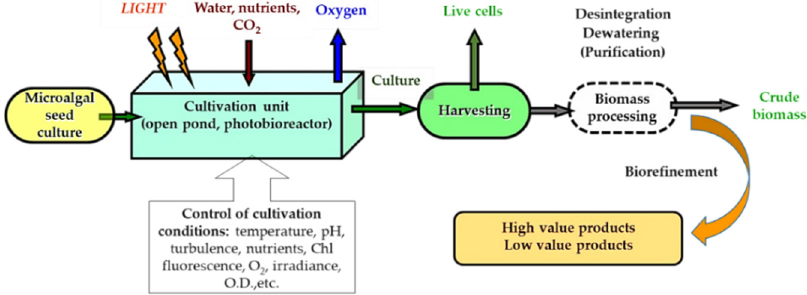
Figure 3. Scheme of microalgae cultivation and downstream processing